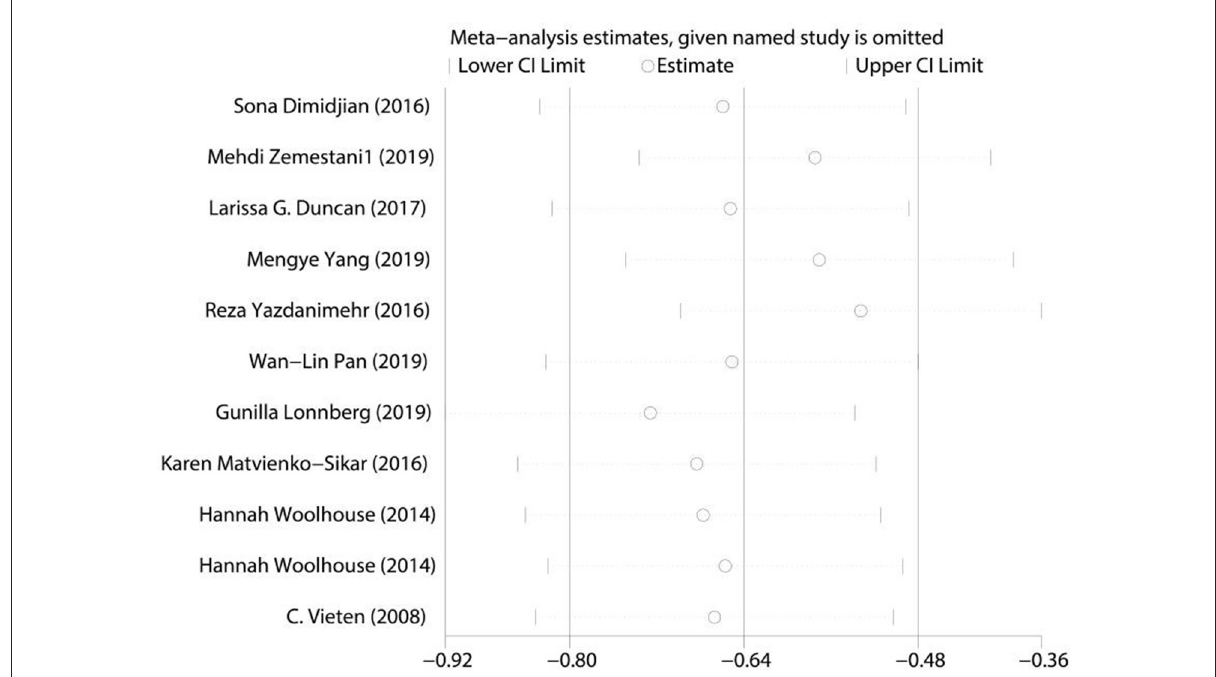
FIGURE5 Sensitivity analysis of mindfulness meditation on depression during pregnancy.